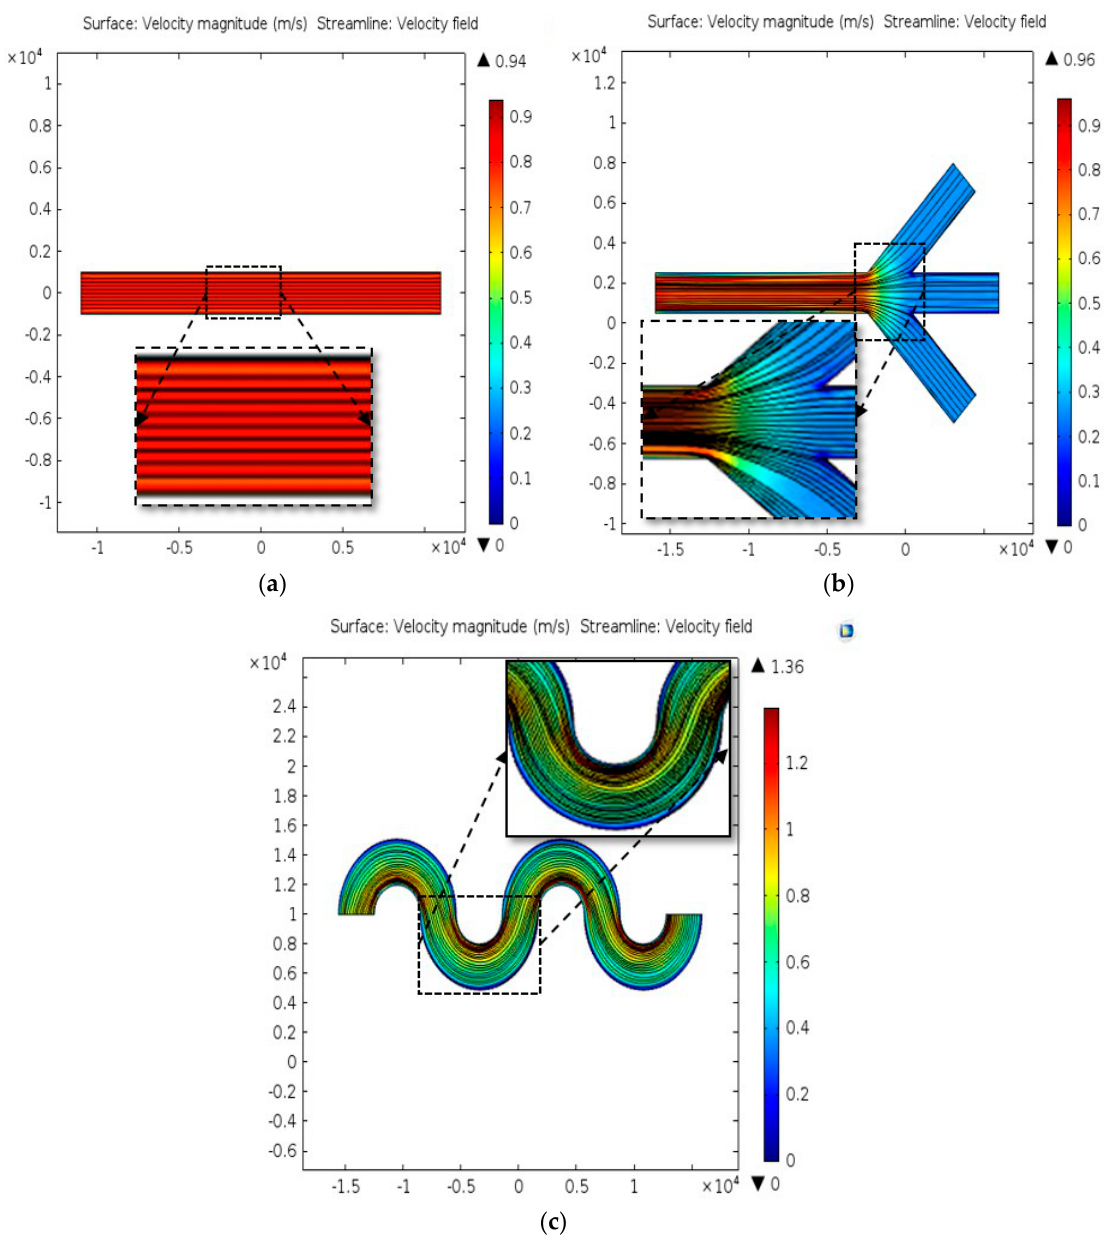
Figure 8. Streamline flow velocity profile in three fluid channels, the inset shows the close-up view of ( a ) the straight channel, ( b ) the branched channel, and ( c ) the serpent-shaped